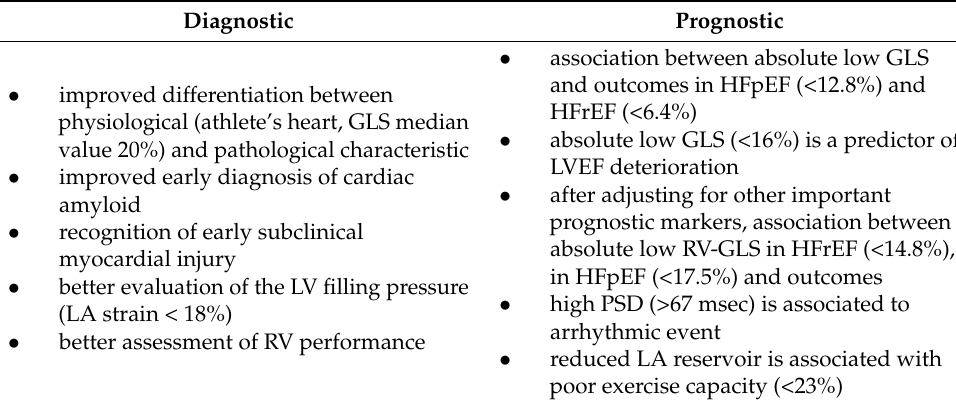
Table 1. Diagnostic and prognostic implication of GLS.